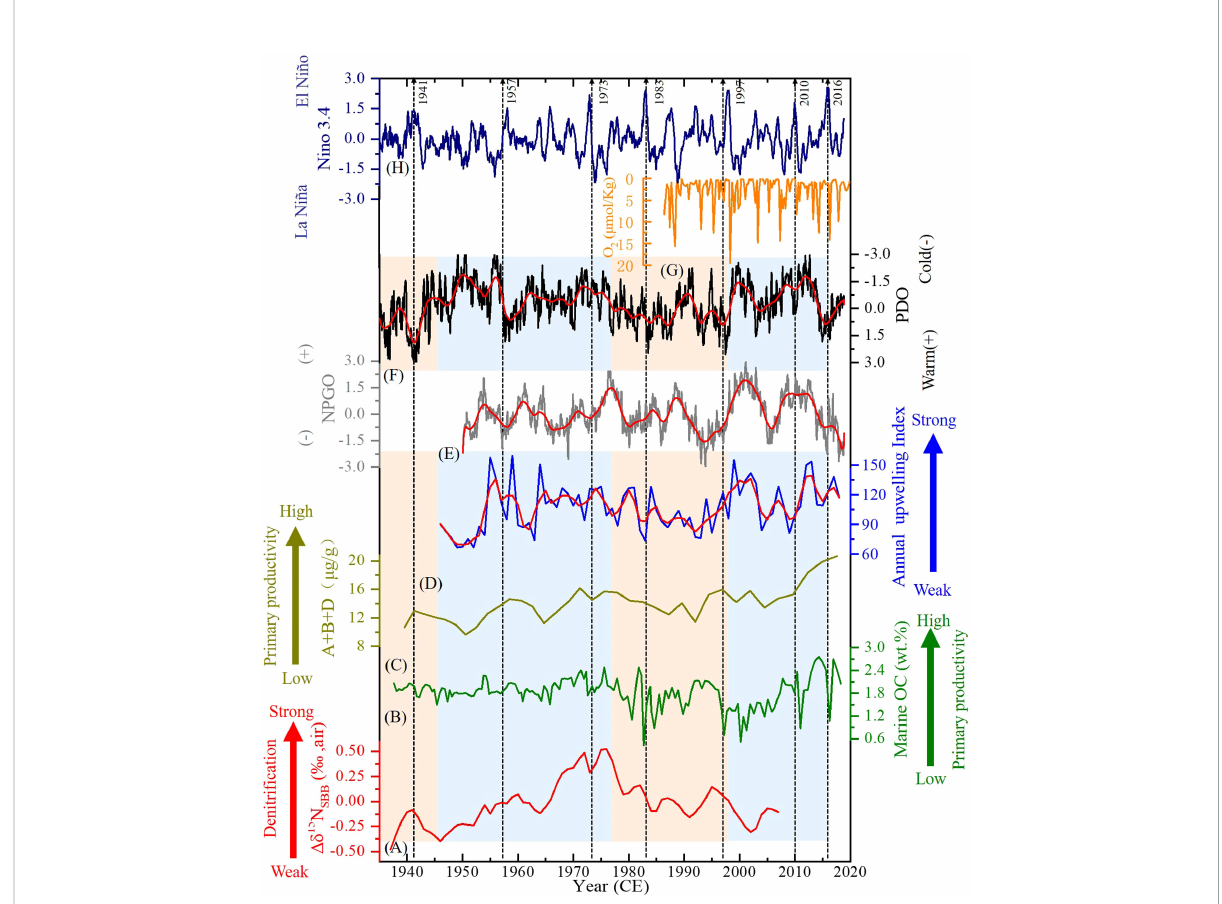
FIGURE 9 Comparisons of the Santa Barbara Basin (SBB) (A) local Dd 15 N ( ‰ ), (B) OC marine (wt.%), (C) marine biomarkers ( m g/g), (D) annual upwelling index, and (G) O 2 content ( m mol/kg) records with (E) North Paci fi c Gyre Oscillation (NPGO) (http://www.o3d.org/npgo/). (F) Paci fi c Decadal Oscillation (PDO) (http://jisao.washington.edu/pdo/PDO), and (H) El Niño – Southern Oscillation (ENSO) (https://www.esrl.noaa.gov/psd/gcos_wgsp/ Timeseries/) records. Strong El Niño events such as in 1941, 1957 – 1958, 1973, 1982 – 1983, 1997 – 1998, 2010, and 2016 are marked. Red lines in panels ( D – F ) represent the results of 3 years smoothed. Orange areas denote warm phase of PDO, whereas blue areas represent cold phase of PDO. Note that the scale of O 2 content and PDO is